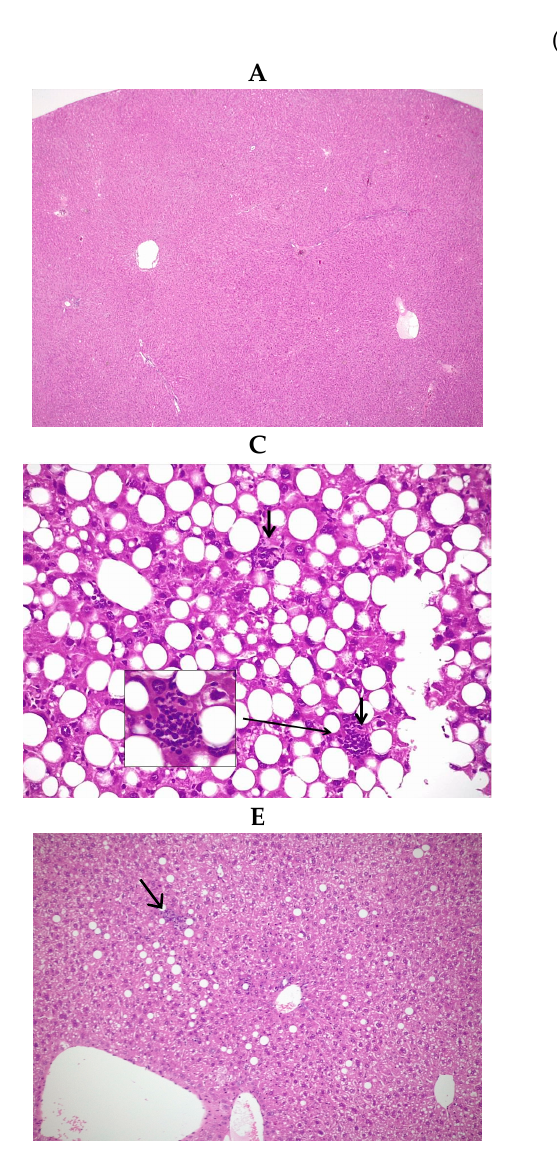
Figure 1. ( a ): Histological evaluation of steatosis and necroinflammation in livers from control, MCDHF, MCDHF + MitoQ, and MCDHF + ASA mice. * p < 0.05 vs. control; # p < 0.05 vs. MCDHF. In livers from MCDHFD mice, extensive steatosis and multiple inflammatory foci were observed; both steatosis and necroinflammation were improved by treatment with MitoQ and ASA. ( b ): ( A ): Control animal: neither steatosis nor inflammation are present; HE original magnification 2.5 × ; ( B ): MCDHF animal: severe macrovesicular steatosis involving more than 90% of hepatocytes; HE original magnification 2.5 × . ( C ): MCDHF same animal as A: inflammatory foci are showed (arrows); HE original magnification 20 × (40 × in the insert). ( D ): MCDHF + MitoQ animal: less severe steatosis is evident, involving about 25% of hepatocytes, inflammation is absent; HE original magnification 5 × ; ( E ): MCDHF + ASA animal: steatosis is about 10% and inflammatory foci are rare (arrow); HE original magnification 20 ×